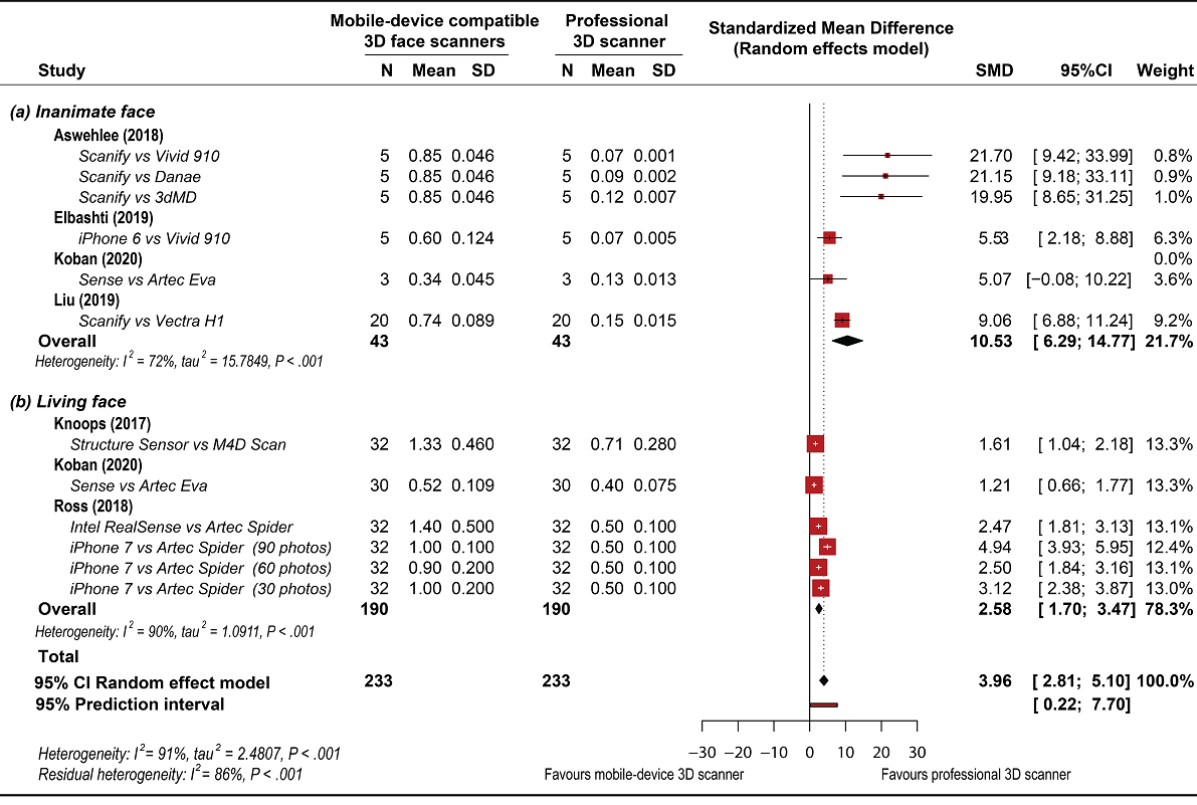
Figure 4. Subgroup meta-analysis results of comparison of facial models obtained using mobile device–compatible face scanners versus professional